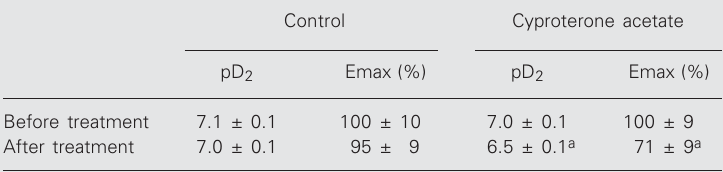
Table 3. Effects of chloroethylclonidine on pD 2 and maximal contractions in response to noradrenaline acting on vas deferens from control and cyproterone acetate-treated